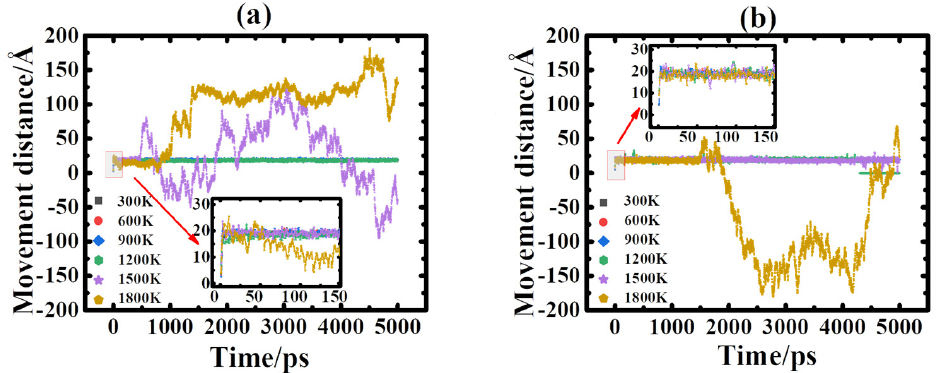
Figure 7. The distribution of binding energies of the different sized IDLs to a vacancy cluster (containing eight vacancies) as a function of their distance when the vacancy clusters is placed along the ( a ) Direction I and ( b ) Direction II, respectively. The inset figure shows the binding energies at a small energy scale.